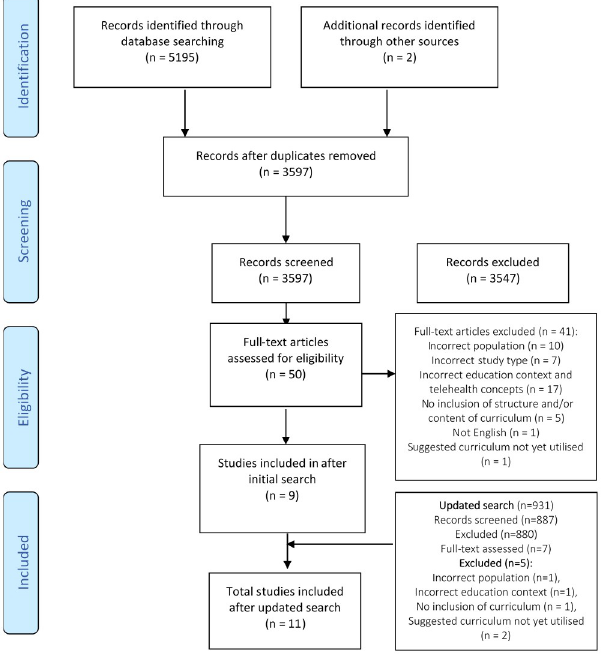
Fig 1. PRISMA scoping review